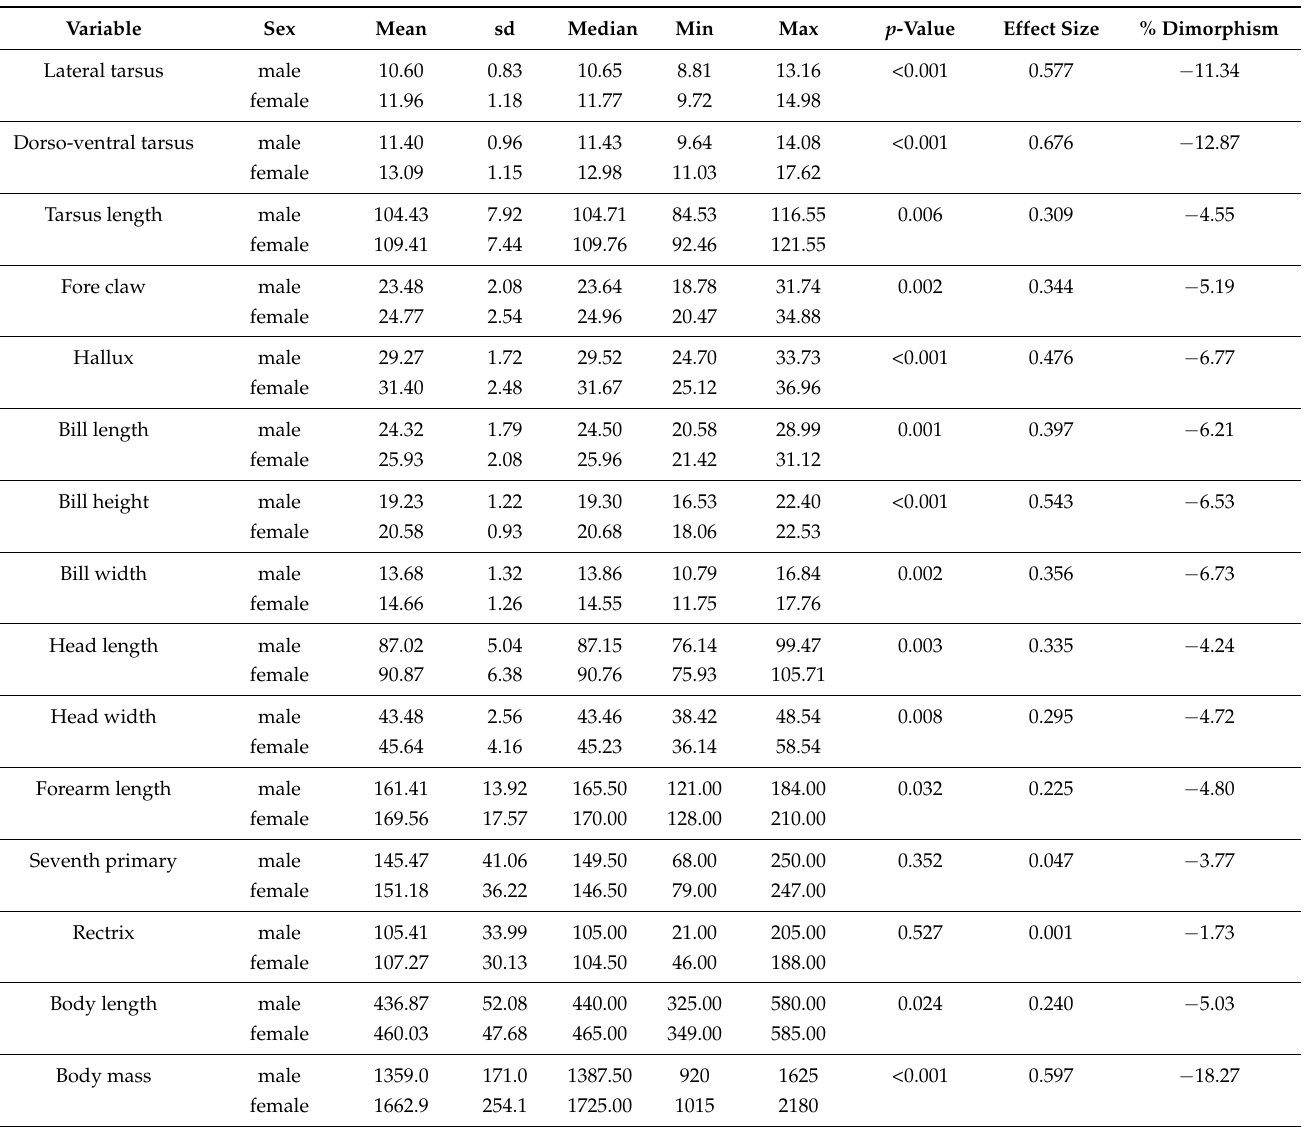
Table 2. Summary statistics and results of the Mann–Whitney test of morphometric measurements of male ( n = 34) and female ( n = 34) Bonelli’s eagles nestlings from eastern Spain sexed by molecular techniques. Values are given in mm except body mass which is given in grams. The importance of each variable in the identification of the sexes with respect to the other variables (effect size) and the percentage of sexual dimorphism are